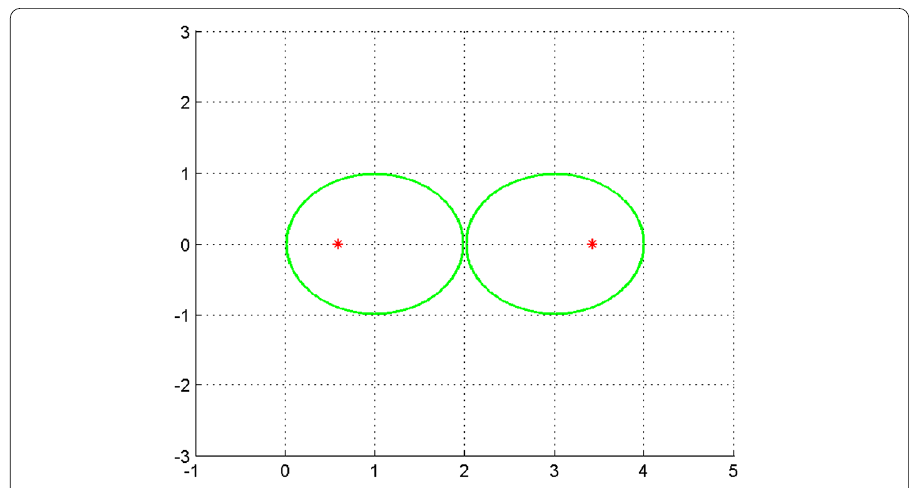
Figure 1 The V-singular value inclusion set (cid:12) ( A ) and the exact V-singular